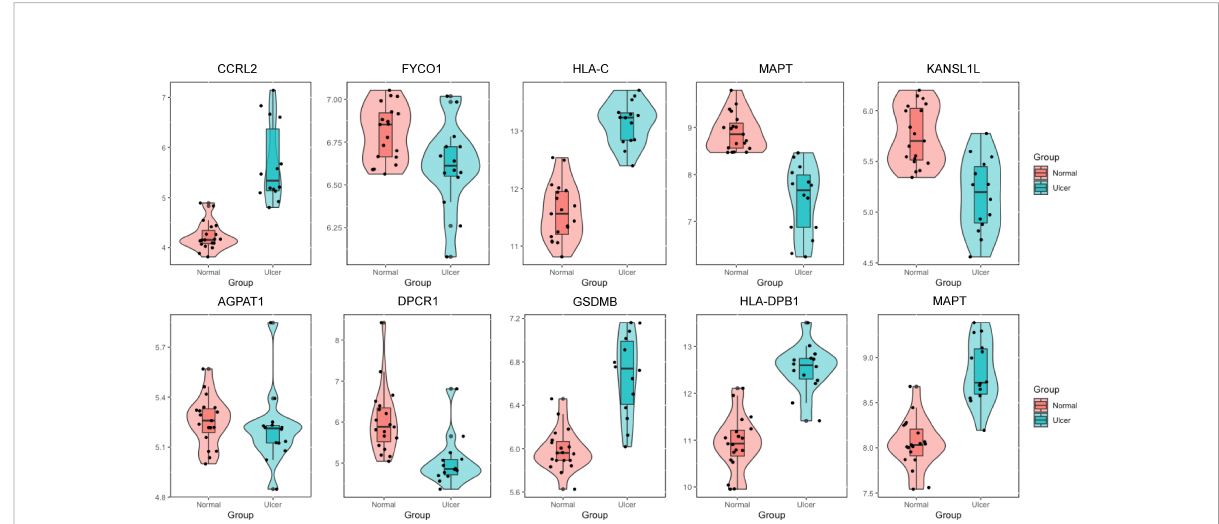
FIGURE 3 The expression levels of selected genes were shown in oral ulcer patients and healthy controls. The expression of genes such as CCRL2, HLA-C, GSDMB, HLA-DPB1 and MAPT were elevated in patients with oral